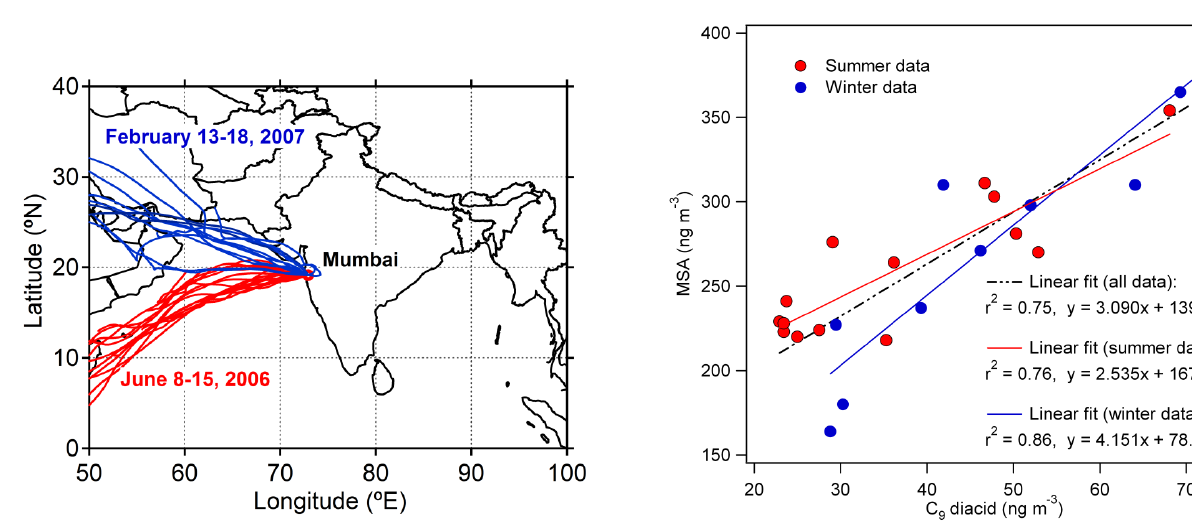
Fig. 5. Correlations between marine source tracers: methanesul- fonate (MSA) and azelaic acid (C 9 diacid) ( r 2 is based on the com- plete data